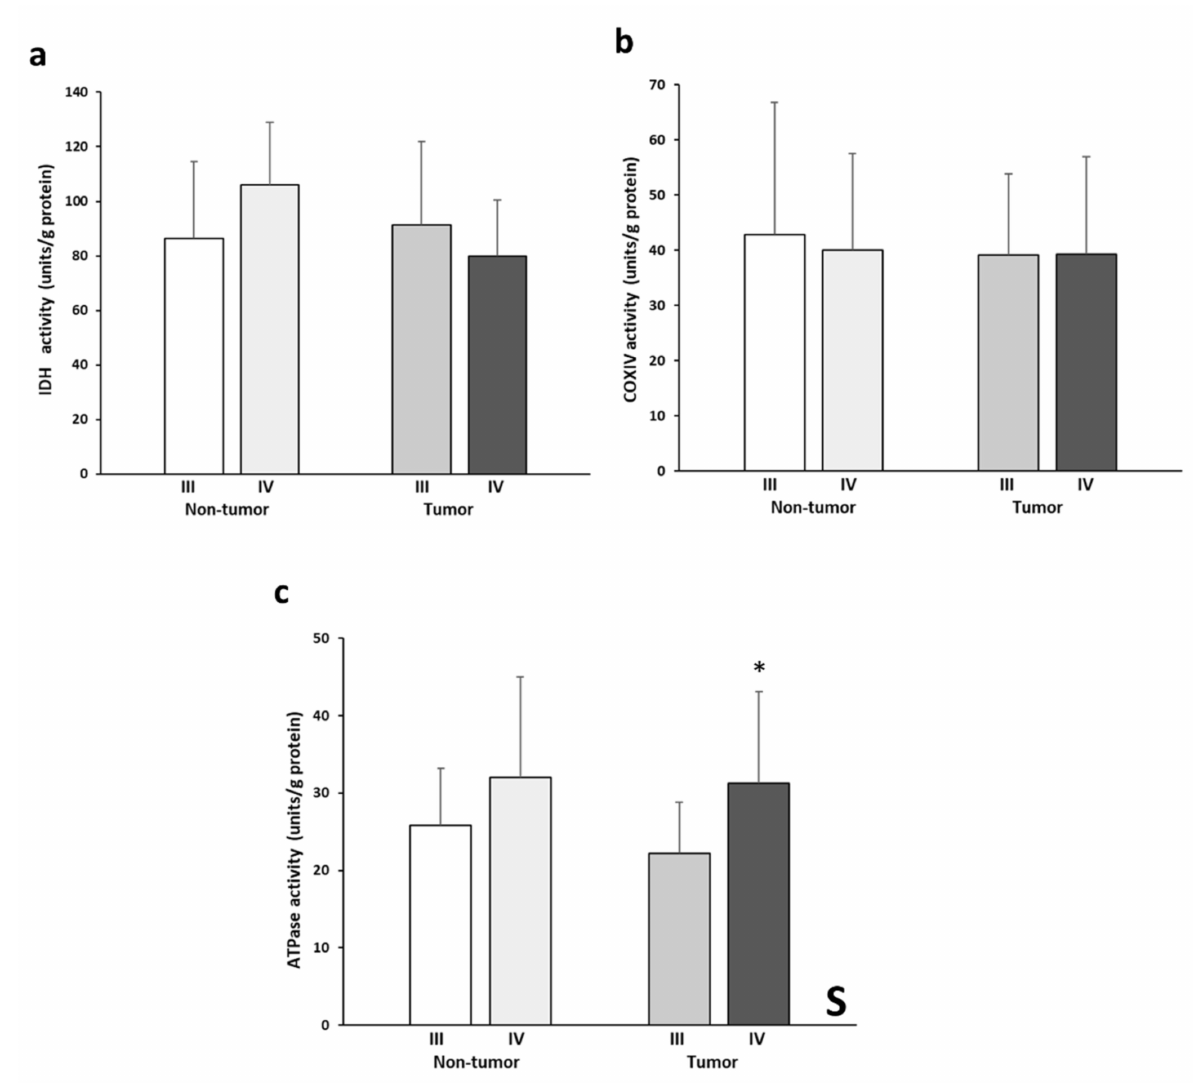
Figure 4. Enzymatic activities of IDH ( a ), COX ( b ), and ATPase ( c ). The data are presented as means ± SD. ANOVA analysis: two-way ( n = 11 per group): S, stage effect; one-way ( n = 11 per group): * difference between stage III and stage